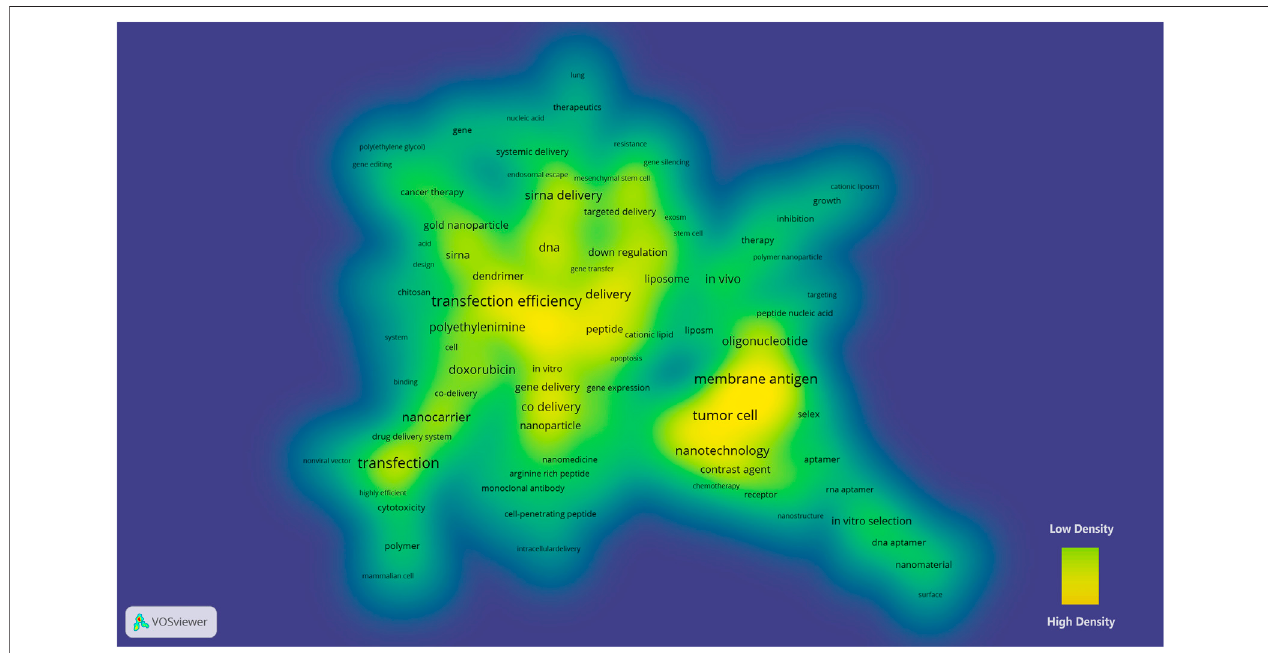
FIGURE 2 | Density map of the keyword co-occurrence network of nanoparticles in nucleic acid – targeted delivery. A higher density represents a closer distance between the nodes and a larger number of neighboring nodes. The color of the map varies from yellow (high density) to green (low density) (van Eck, 2021).